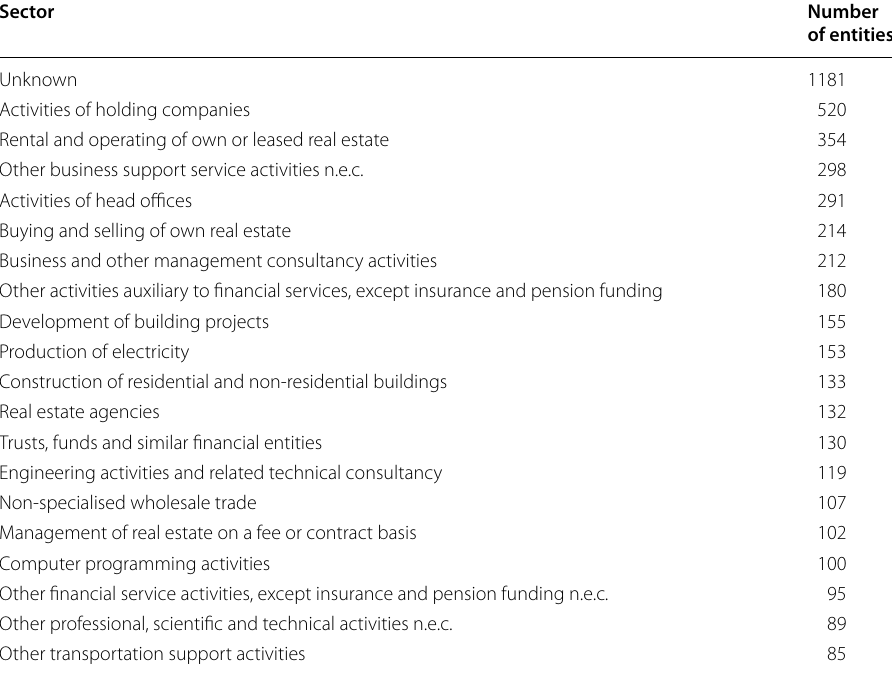
Table 7 Top 20 influential sectors using IMM Sector